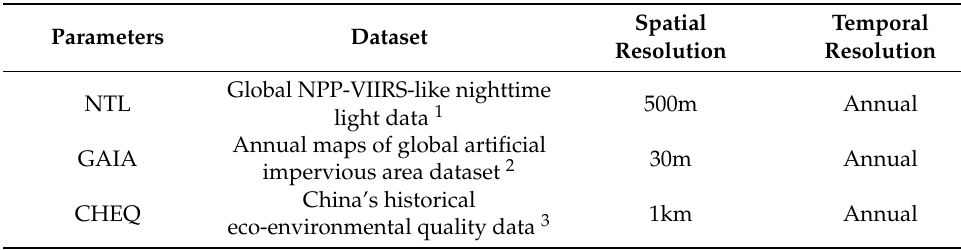
Table 1. Description of the data used in the